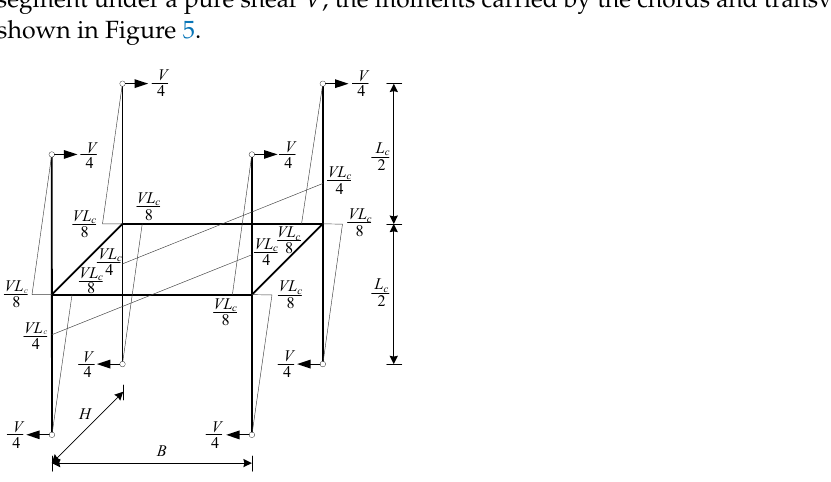
Figure 5. Moment diagram of a typical Vierendeel truss segment under the pure shear V .